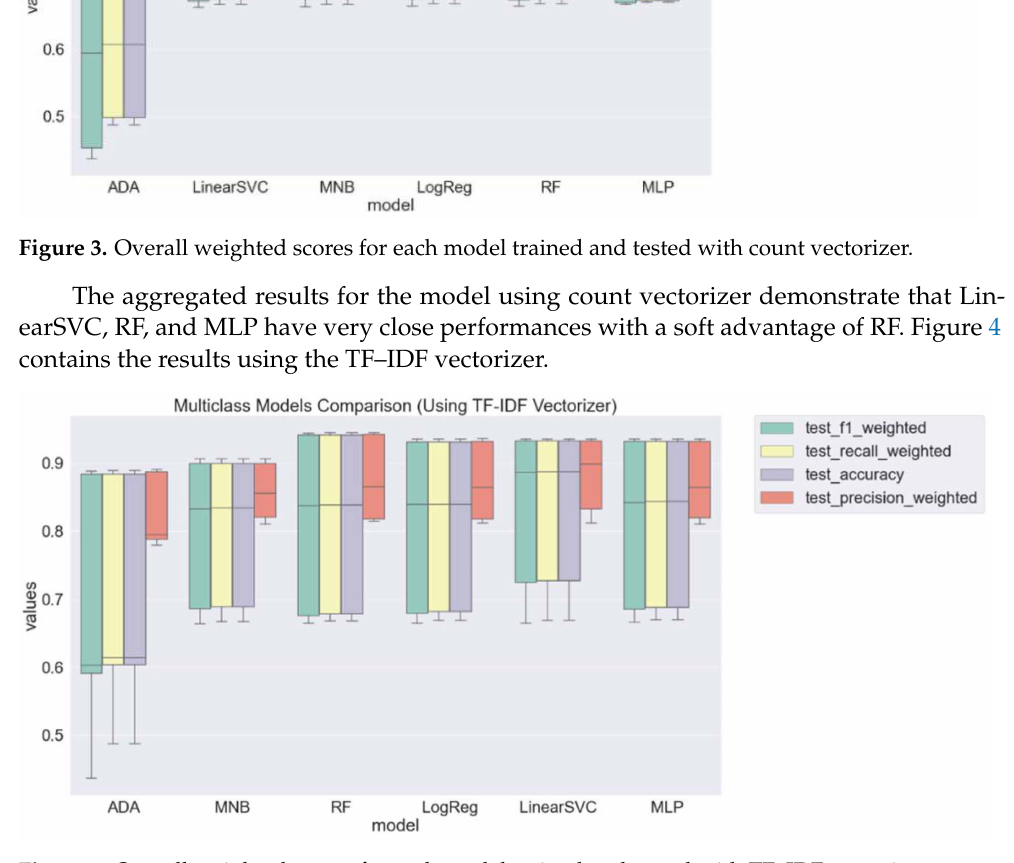
Figure 4. Overall weighted scores for each model trained and tested with TF–IDF